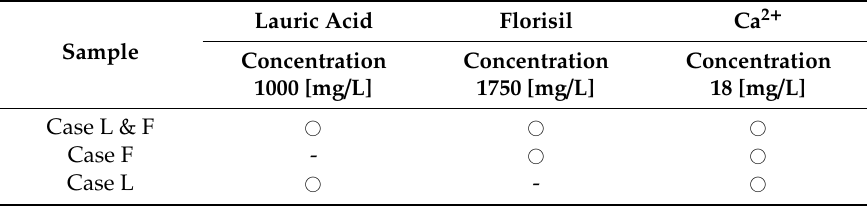
Table 1. Concentration of the types of simulated wastewater used in the experiment.